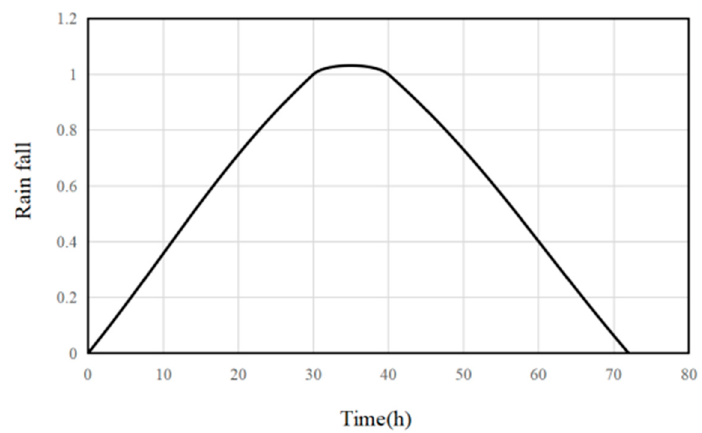
Figure 3. Finite element model.